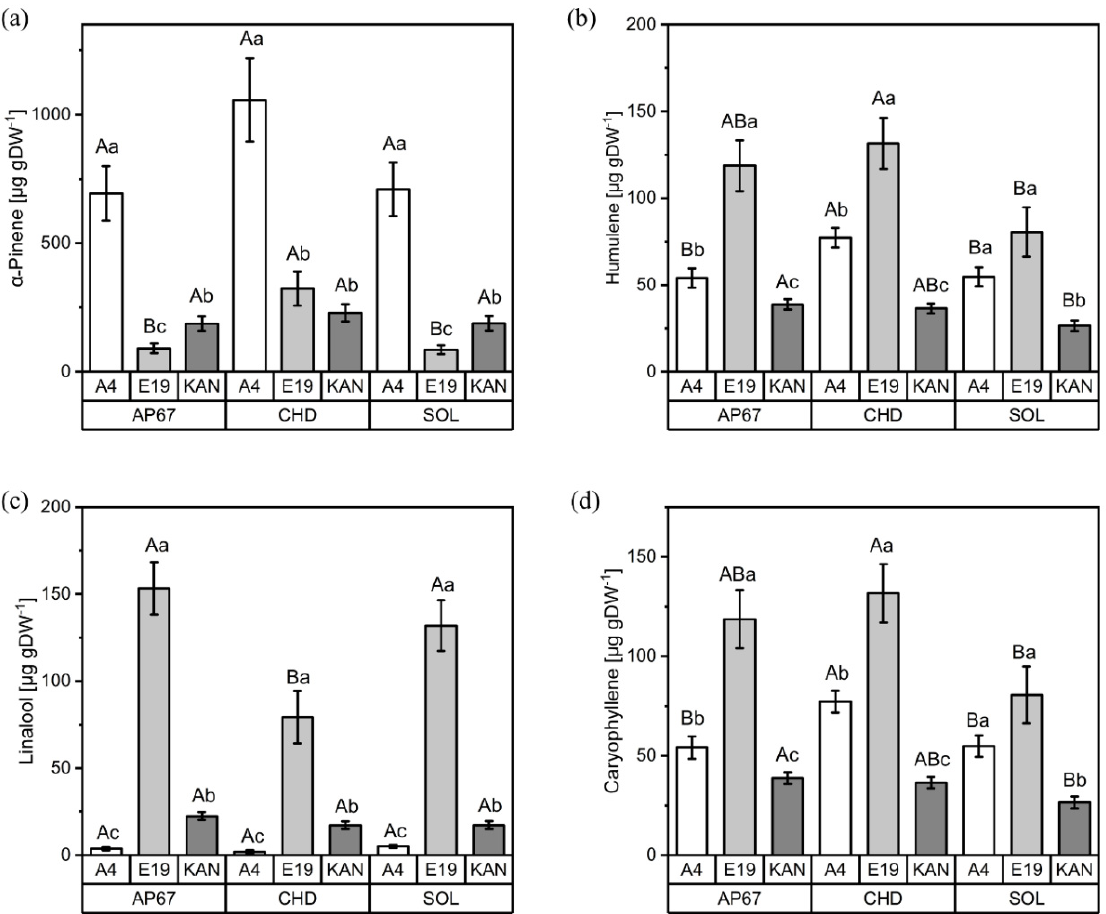
Figure 5. Concentrations ( μ g g DW − 1 ) of α -pinene ( a ), humulene ( b ), linalool ( c ) and caryophyllene ( d ) for the different strains (A4, E19 and KAN) under the three light spectra (SOL, AP67 and CHD). Means covered by at least one identical letter did not differ significantly, as indicated by a Tukey test ( α = 0.05). Lowercase letters indicate comparisons between strains within light spectra; uppercase letters indicate comparisons between light spectra within strains. Error bars indicate the standard errors of the means ( n = 3).